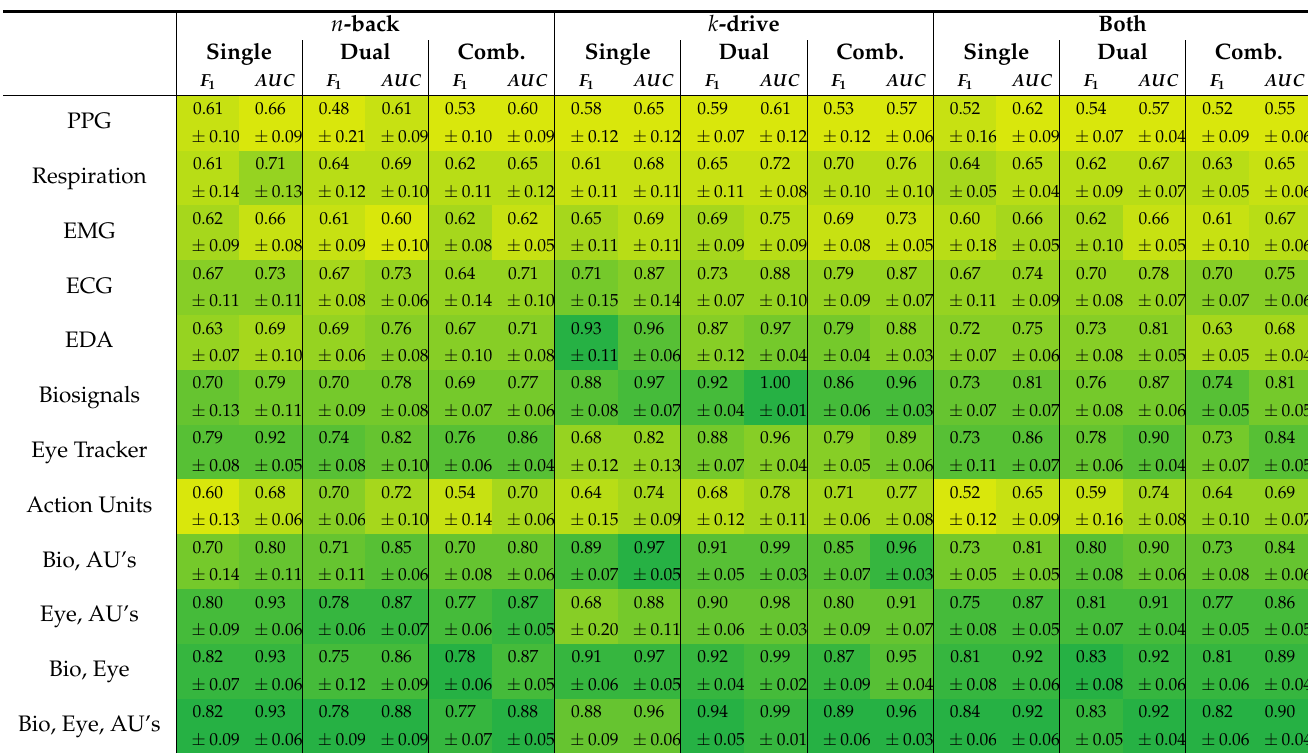
Table 8. Tabular data visualization of F 1-Score and AUC scores for binary classification task. Rows contain various sets of features used for classification: Using only one modality (ECG, EDA, etc.) or combinations of various modalities: Bio containing all biosignal modalities, described in Section 2.8, AU’s containing all action units extracted from video data and Eye containing all eye tracker features. The columns are separated into experiments described in Sections 2.3 and 2.4 and the combination of both experiments. The different groups for this two-level classification, detecting low and high cognitive load are described in Section 2.13. The second-level hierarchical columns differentiate between single and dual-task load (e.g., for the n-back task: visual vs. visual + auditive) and the combinations of similar cognitive load levels by intensities in Comb. , described in Section 2.13. All results were acquired using the evaluation pipeline described in Section 2.14 with nested cross- validation protocol and XGBoost as model for